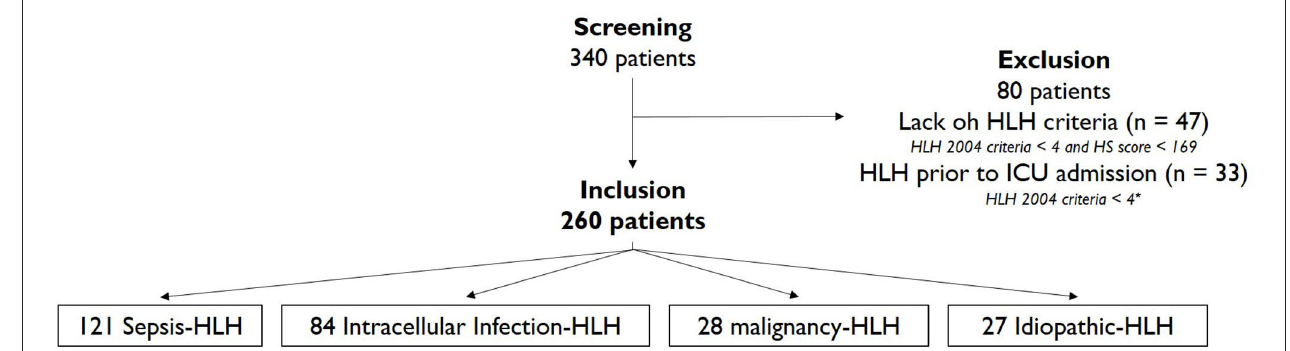
FIGURE 1 | Flow Chart. HLH-2004 criteria < 4 = lack of at least 3 criteria among ferritin, triglycerides, fibrinogen, hemophagocytosis or